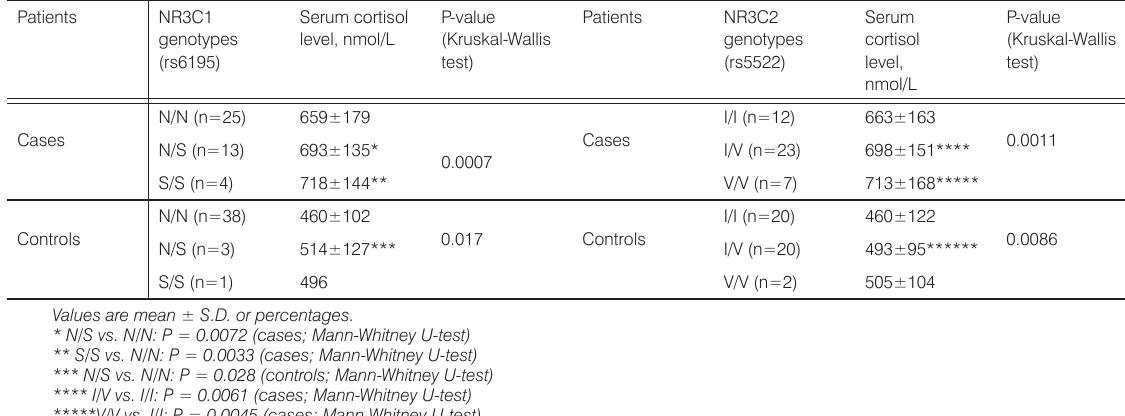
Table 3. Serum cortisol levels in carriers of different genotypes of rs6195 (NR3C1) and rs5522 (NR3C2)